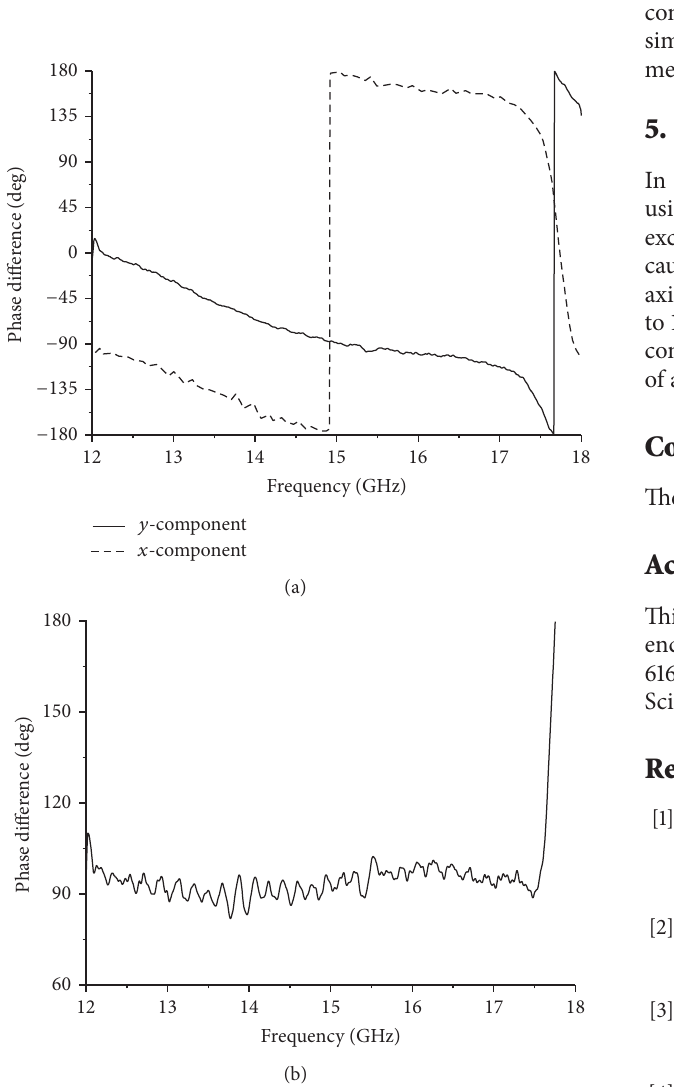
Figure 16: The measured reflectance.